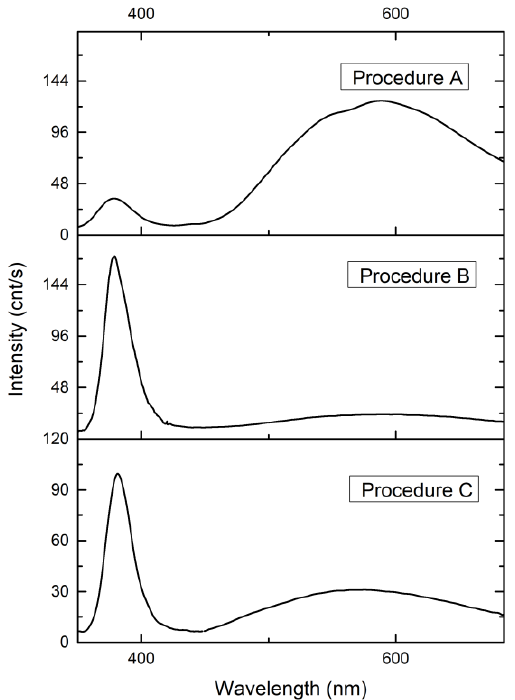
Figure 4. Room temperature photoluminescence spectra of the ZnO nanorods grown in 0.5% forma- mide for each of the three procedures A, B and C.